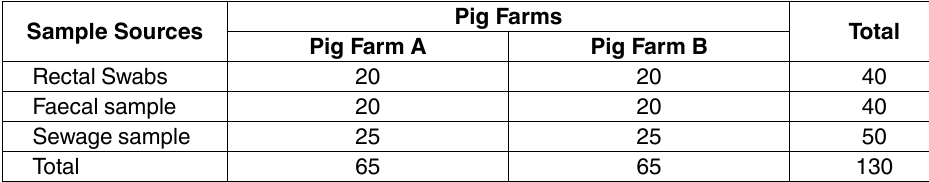
table 1. Details of samples collected from pig farms sample sources